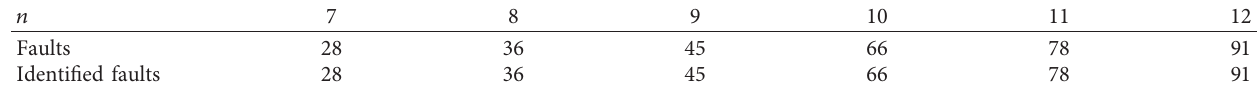
Table 1: Number of faulty nodes identified by the two-round algorithm applied to an n -dimensional hypercube.